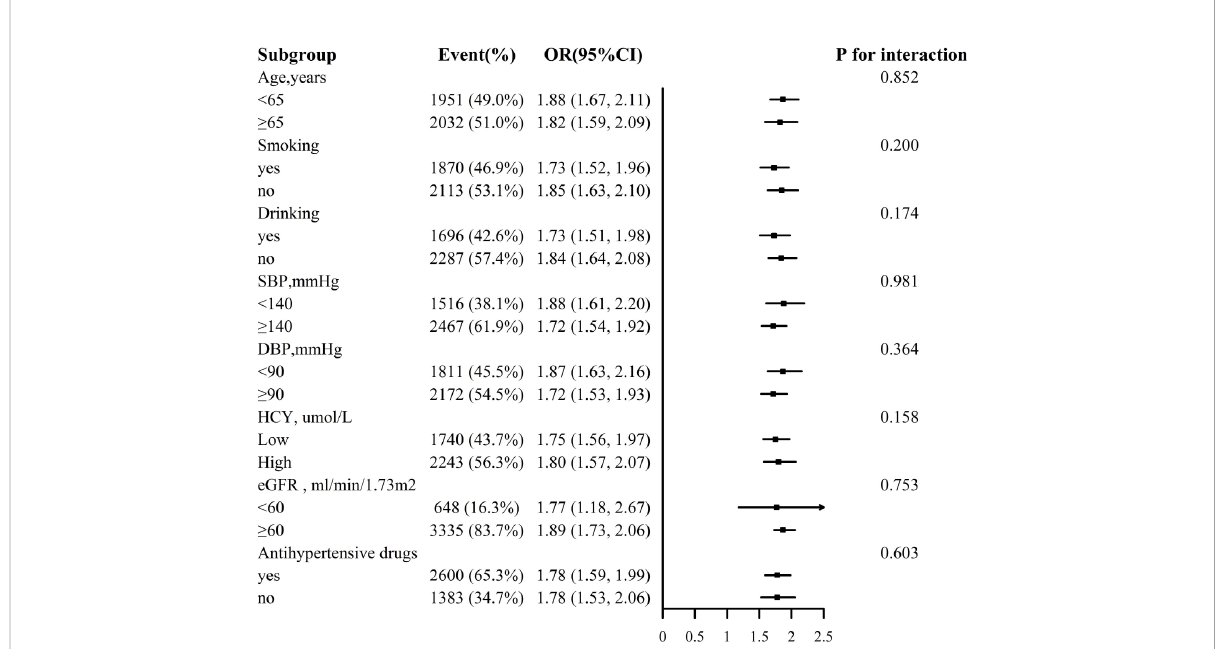
FIGURE 3 Association between ln VAI and hyperuricemia in males in various subgroups. The models adjusted for age, smoking, drinking, BMI, SBP, DBP, TC, LDL-C, HDL, HCY, eGFR, anti-hypertensive drugs, glucose-lowering drugs except for the stratify.